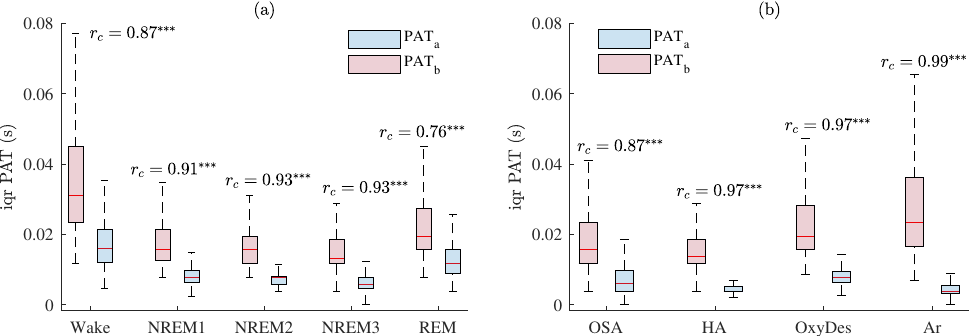
Figure 12. The interquartile range of PAT across all MESA subjects with estimated matched-pairs r c values in: ( a ) different sleep stages; ( b ) different events related to sleep-disordered breathing. Results are shown before and after PAT post-processing, PAT b and PAT a , respectively. p < 0.001 and r c ≥ 0.50 is marked ∗∗∗ .